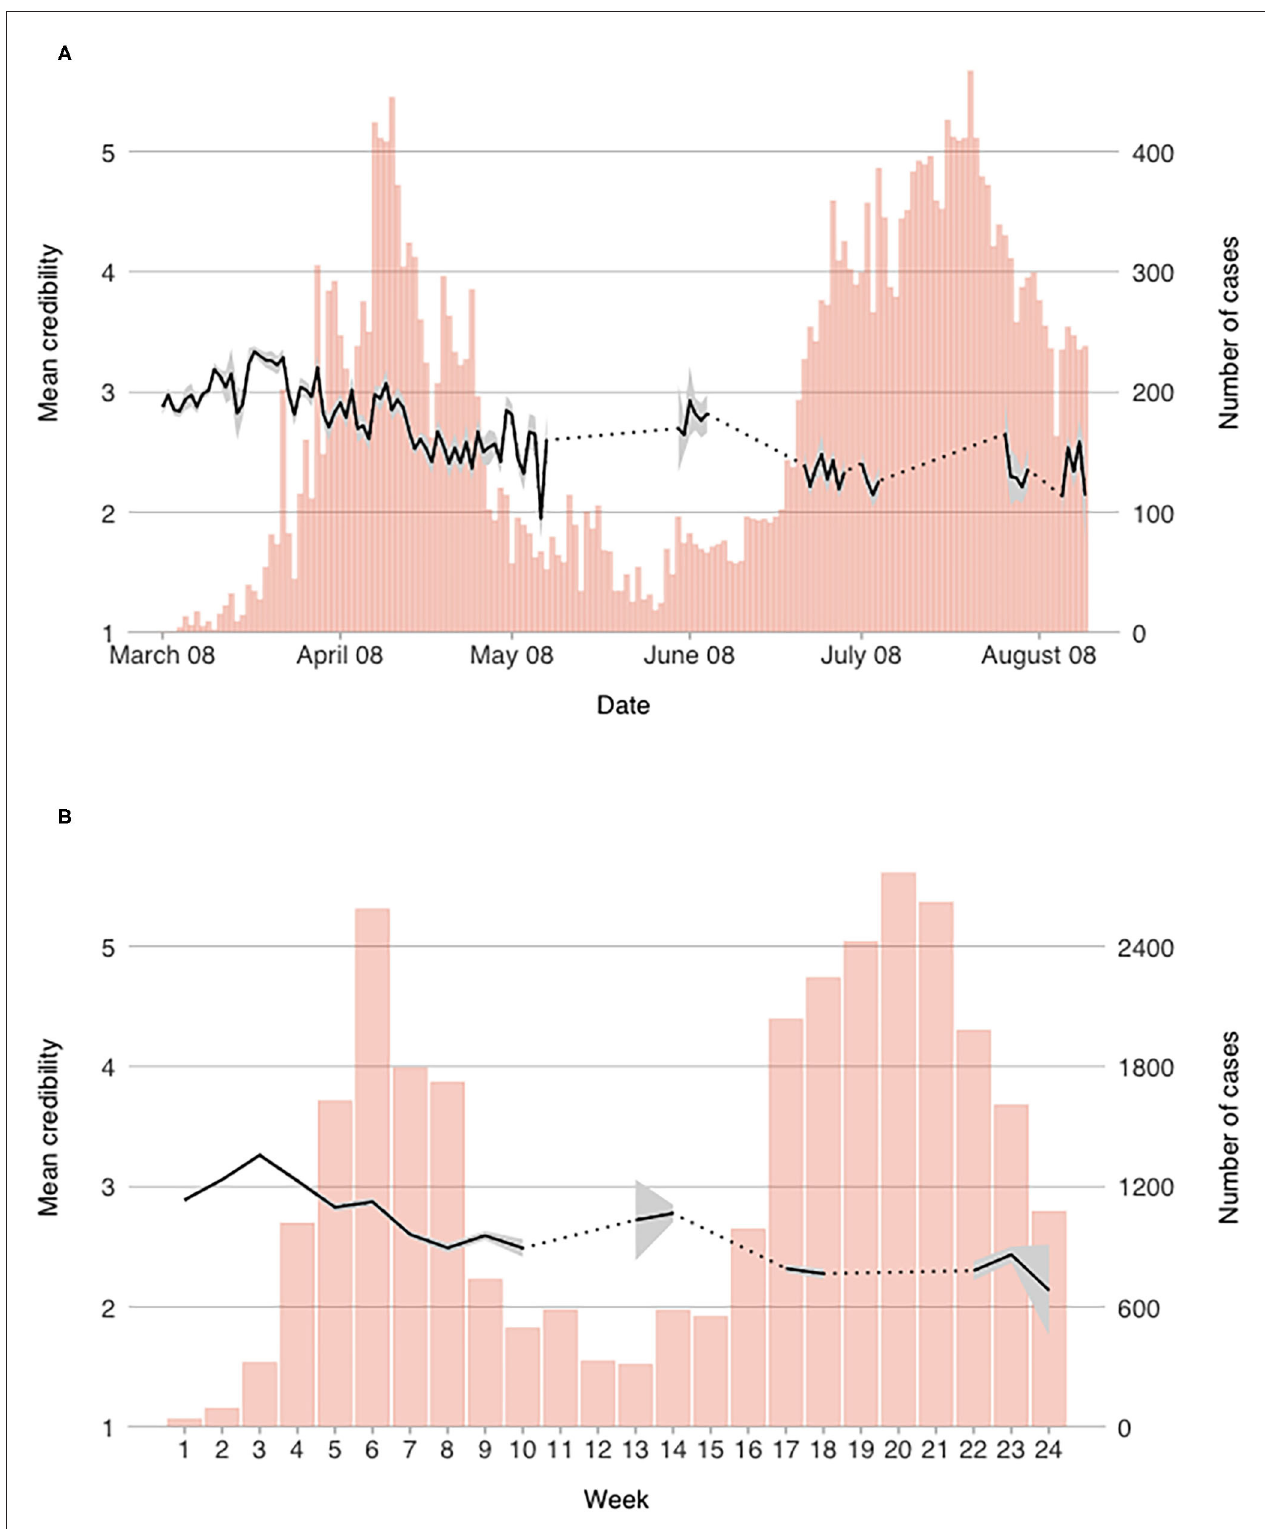
FIGURE 1 | Mean perceived credibility of information scores on a (A) daily, and (B) weekly level.